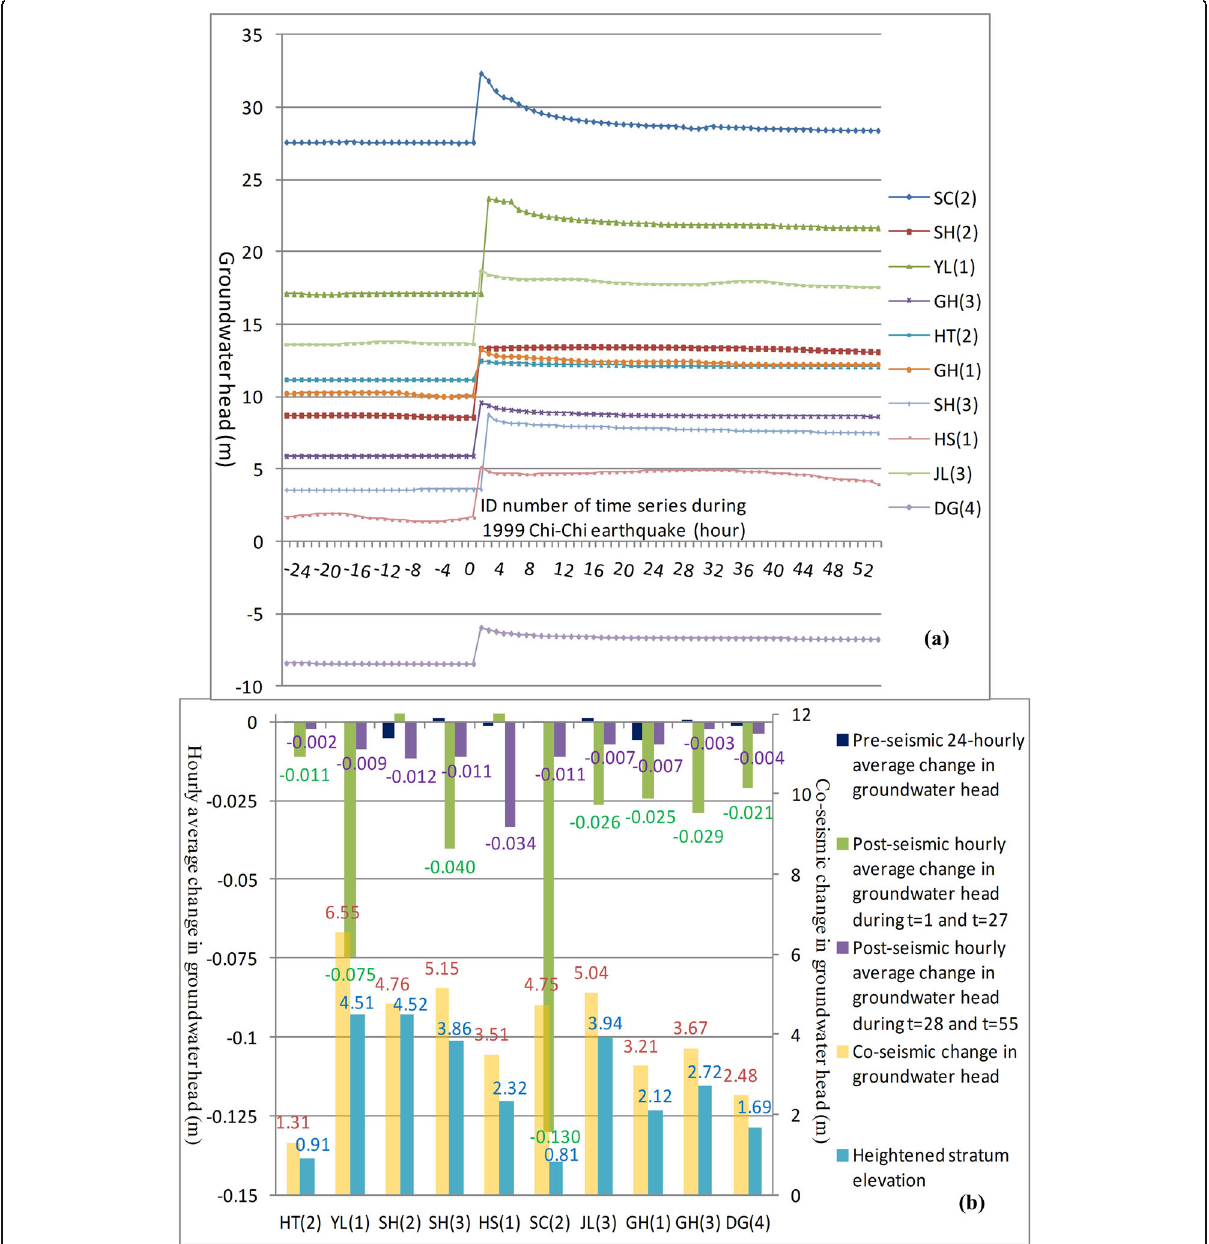
Fig. 5 a Measured co-post-seismic groundwater head fluctuation in Chou-Shui River alluvial fan during the 1999 M W = 7.5 Chi-Chi Earthquake. b Comparison of pre-co-post-seismic change in groundwater